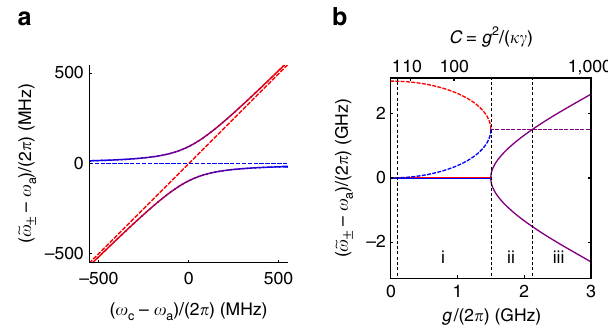
Figure 1 | Lowest-lying normal modes of the atom–cavity system. ( a ) Eigenfrequencies o (cid:3) of the undamped Hamiltonian ^ H . Dashed lines: uncoupled atom (blue) and cavity (red). Solid lines: avoided crossing of the eigenfrequencies o (cid:3) of the dressed system, as given by equation (2) with g /(2 p ) ¼ 95MHz. Colour indicates the relative amplitudes of the bare states | m ,0 i (more blue) and | k ,1 i (more red) in the eigenstate. ( b ) Complex eigenvalues ~ o (cid:3) , given in equation (3) for the non-Hermitian effective Hamiltonian ^ H eff ¼ ^ H (cid:2) i k ^ a y ^ a (cid:2) i g ^ s y ^ s , taking o c ¼ o a and f k ; g g = ð 2 p Þ ’ f 3000 ; 3 g MHz. Solid curves: eigenfrequencies Re ð ~ o (cid:3) Þ . Dashed curves: damping rates (cid:2) Im ~ o (cid:3) ð Þ . Zones (i), (ii) and (iii) correspond respectively to the Purcell regime, the intermediate regime and the strong coupling